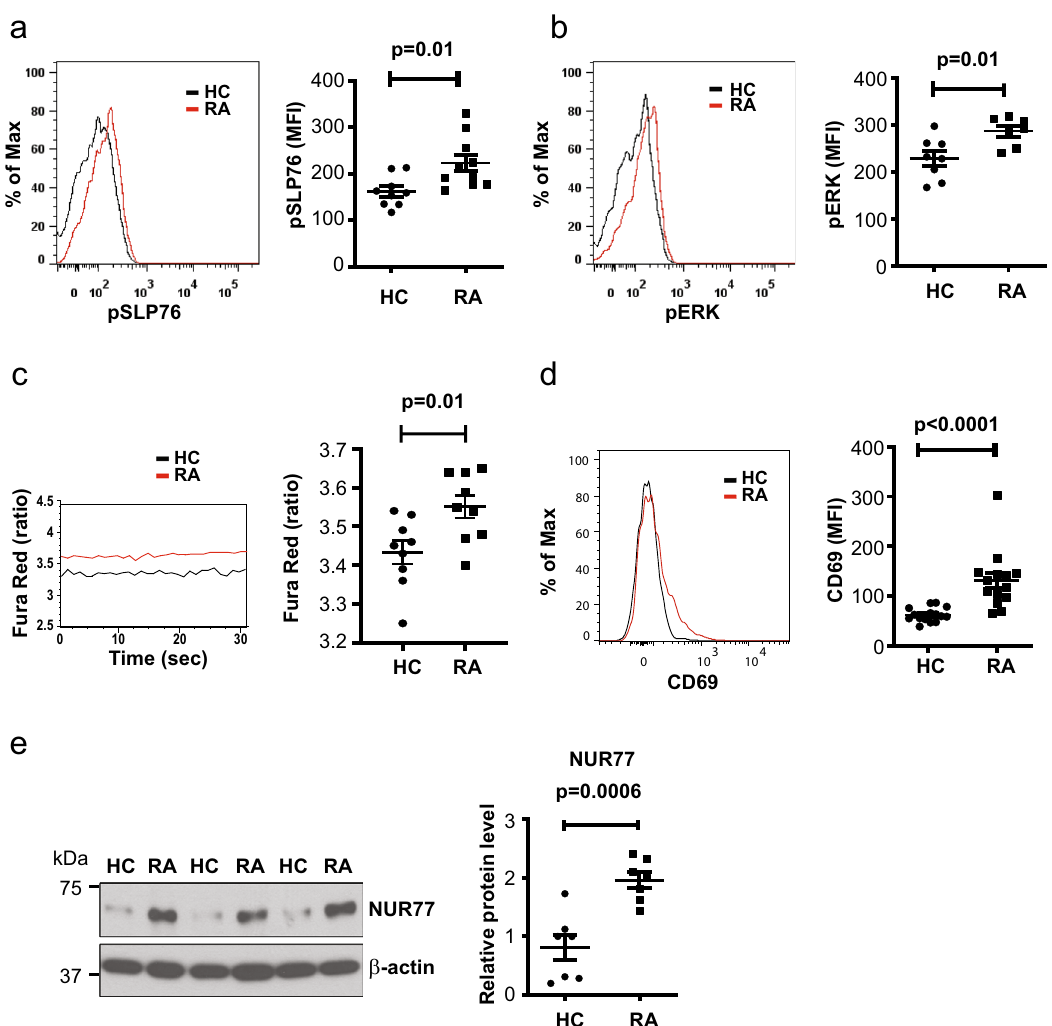
Fig. 1 Constitutively activated TCR signaling in peripheral naive RA CD4 + T cells. Peripheral blood mononuclear cells (PBMCs) were analyzed by fl ow cytometry directly ex vivo without prior in vitro stimulation. Samples of rheumatoid arthritis (RA) patients and healthy controls (HCs) were always run in parallel. a Representative histograms and mean fl uorescence intensity (MFI) of phosphorylated SLP76 (Y128) in gated CD3 + CD4 + CD45RA + CD62L + naive CD4 + T cells from HC ( n = 9) and RA ( n = 10) patients are shown. Gating strategies for naive CD4 + T cells is shown in Supplementary Fig. 1a. b Representative histograms and MFI of phosphorylated ERK (Thr202/Tyr204) in CD3 + CD4 + CD45RA + CD62L + naive CD4 + T cells from HC ( n = 8) and RA ( n = 7) patients. c Representative tracing of Fura Red ratios (left) and shifts in Fura Red fl uorescence (at 406 and 532 nm) in naive CD4 + T cells from HC ( n = 9) and RA ( n = 9) patients (right). d Representative histograms of CD69 expression in CD3 + CD4 + CD45RA + CD62L + naive T cells (left) and data from HC ( n = 15) and RA ( n = 14) patients (right). e NUR77 expression in isolated naive CD4 + T cells shown as representative immunoblots (left) and plots of relative densities from HC ( n = 7) and RA ( n = 7) normalized to β -actin (right). Uncropped Western blots in Supplementary Fig. 9. All data are presented as dot plots with mean ± SEM. All statistical analyses were performed with unpaired two-tailed Student ’ s t test. Source data are provided as a Source Data fi